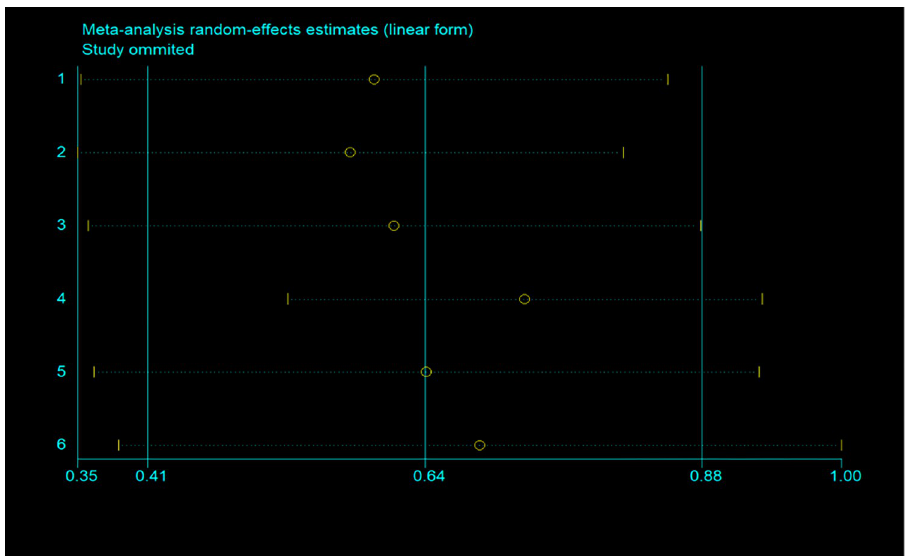
Fig 4. Plot of sensitivity analysis by excluding one study each time and the pooling estimate for the rest of the studies (for incidence of periodontitis in